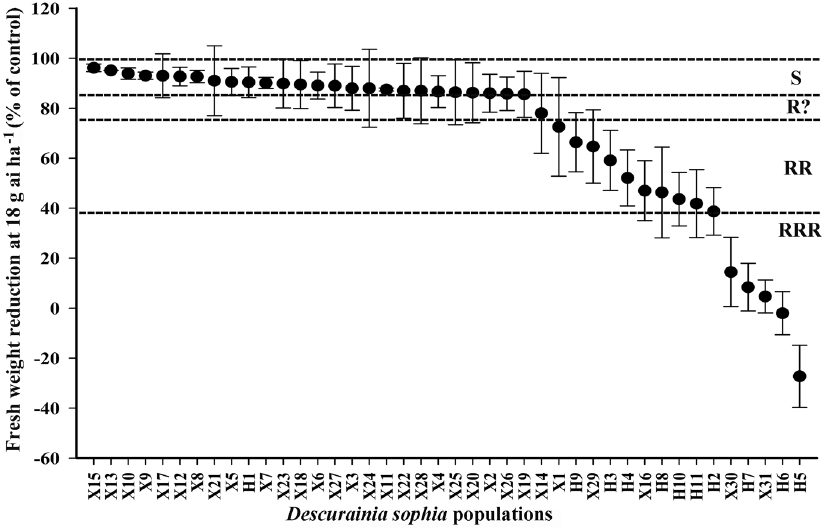
Figure 1. The fresh weight reduction rate of 42 D. sophia populations under the discriminating dose of tribenuron-methyl at 18 g ai ha −1 from Henan and Xinjiang. According to “R” resistance rating system, the D. sophia populations were divided into: (1) RRR (high resistance), fresh weight reduction between 0 and 38.1%; (2) RR (resistance), fresh weight reduction between 38.1 and 76.1%; (3) R? (potential resistance), fresh weight reduction between 76.1 and 85.6%; (4) S (susceptible), fresh weight reduction between 85.6 and 100%; Each point represents the mean ± SD of three